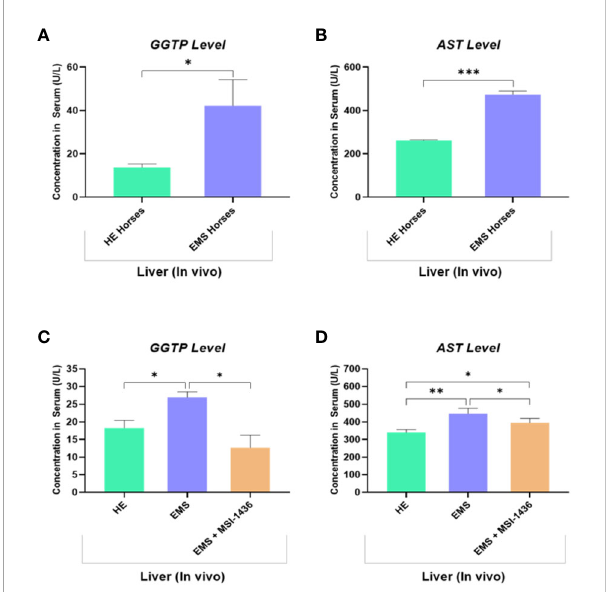
FIGURE 7 Liver function evaluation in healthy and EMS horses. Bar charts depicting the serum levels of GGTP (A) and AST (B) measured in healthy and EMS horses before treatments. Bar charts depicting the serum levels of GGTP (C) and AST (D) measured in healthy and EMS horses following 4 weeks treatment with MSI-1436 or Placebo. Data are presented as a mean value obtained from measurments ± SD. Statistical signi fi cance was marked as follows: *p-value < 0.05; **p < 0.01 and ***p-value <